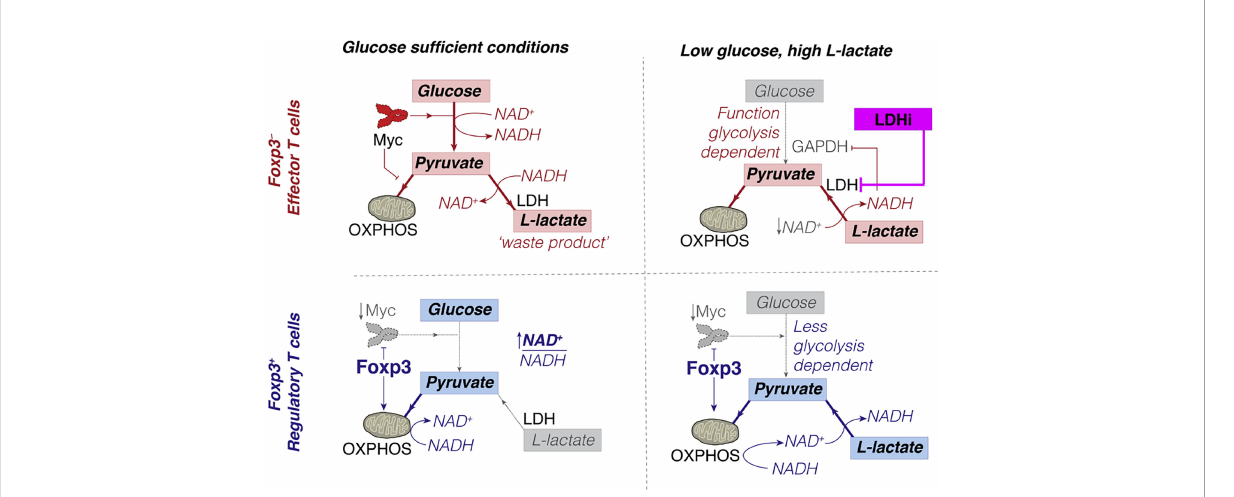
FIGURE 4 Conceptual model of how Foxp3+ Treg can escape the suppressive effects of low glucose, high L-lactate environments. Copyright © 2016 Elsevier